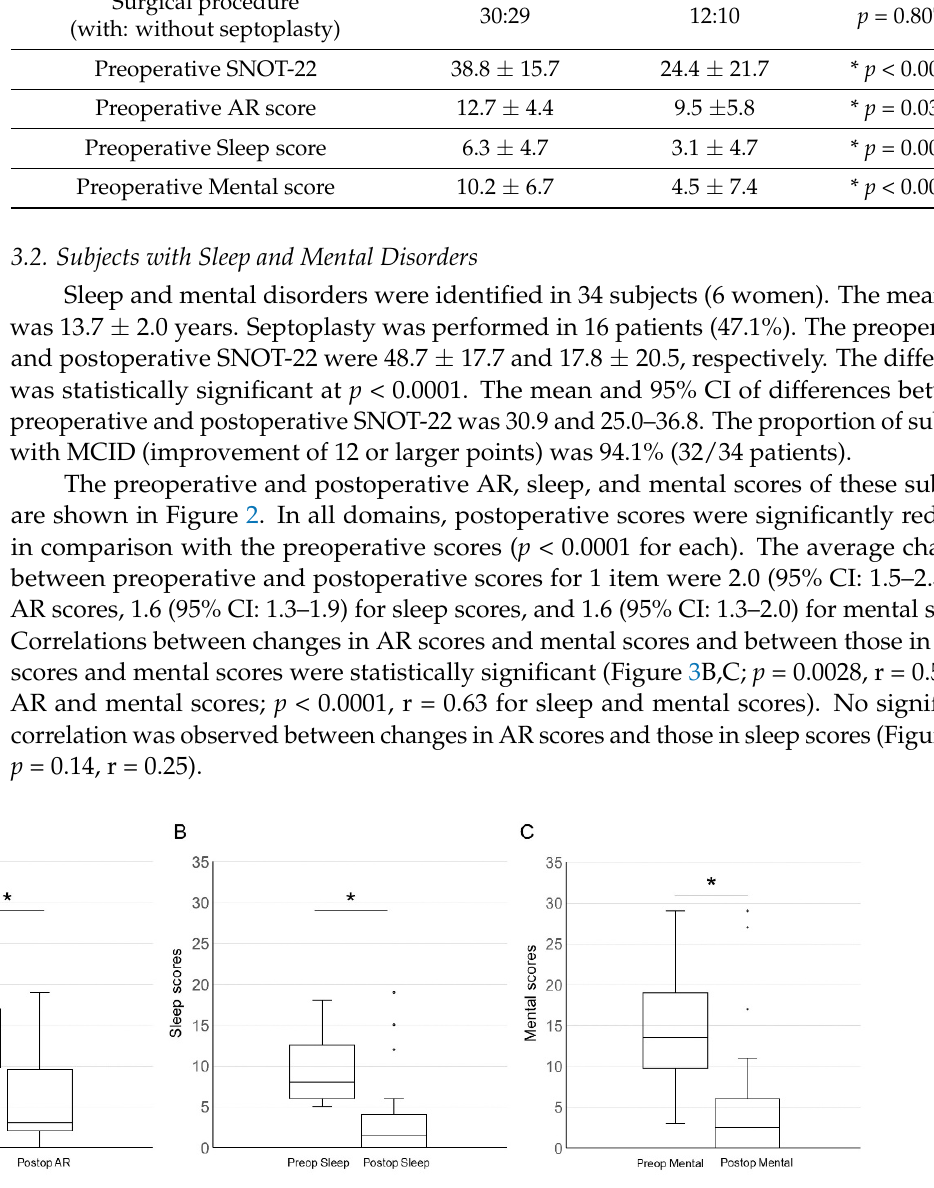
Table 1. Demographic characteristics, surgical procedures, and preoperative scores in subjects with or without MCID. Asterisks (*) indicate statistical significance by the Mann–Whitney U-test. . MCID + ( n = 59) MCID − ( n = 22) Statistics Sex (woman:man) 10:49 7:15 Age (years) 30:29 12:10 p = 0.8071 Preoperative SNOT-22 38.8 ± 15.7